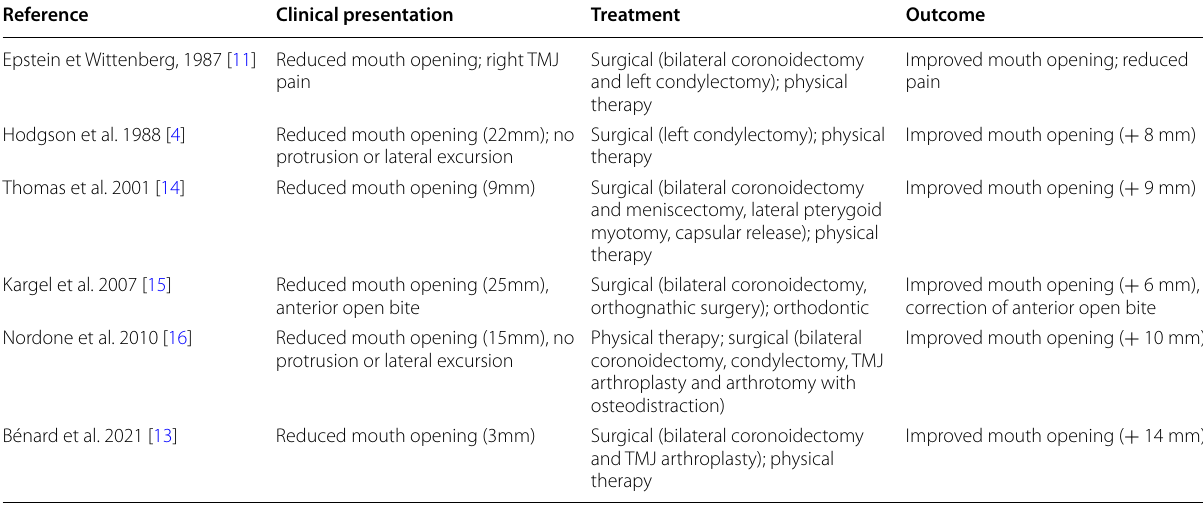
Table 1 Previously published case-reports of maxillo-facial management of adult AMC patients with TMJ involvement and reduced mouth opening (adapted from Bénard et al. 2021